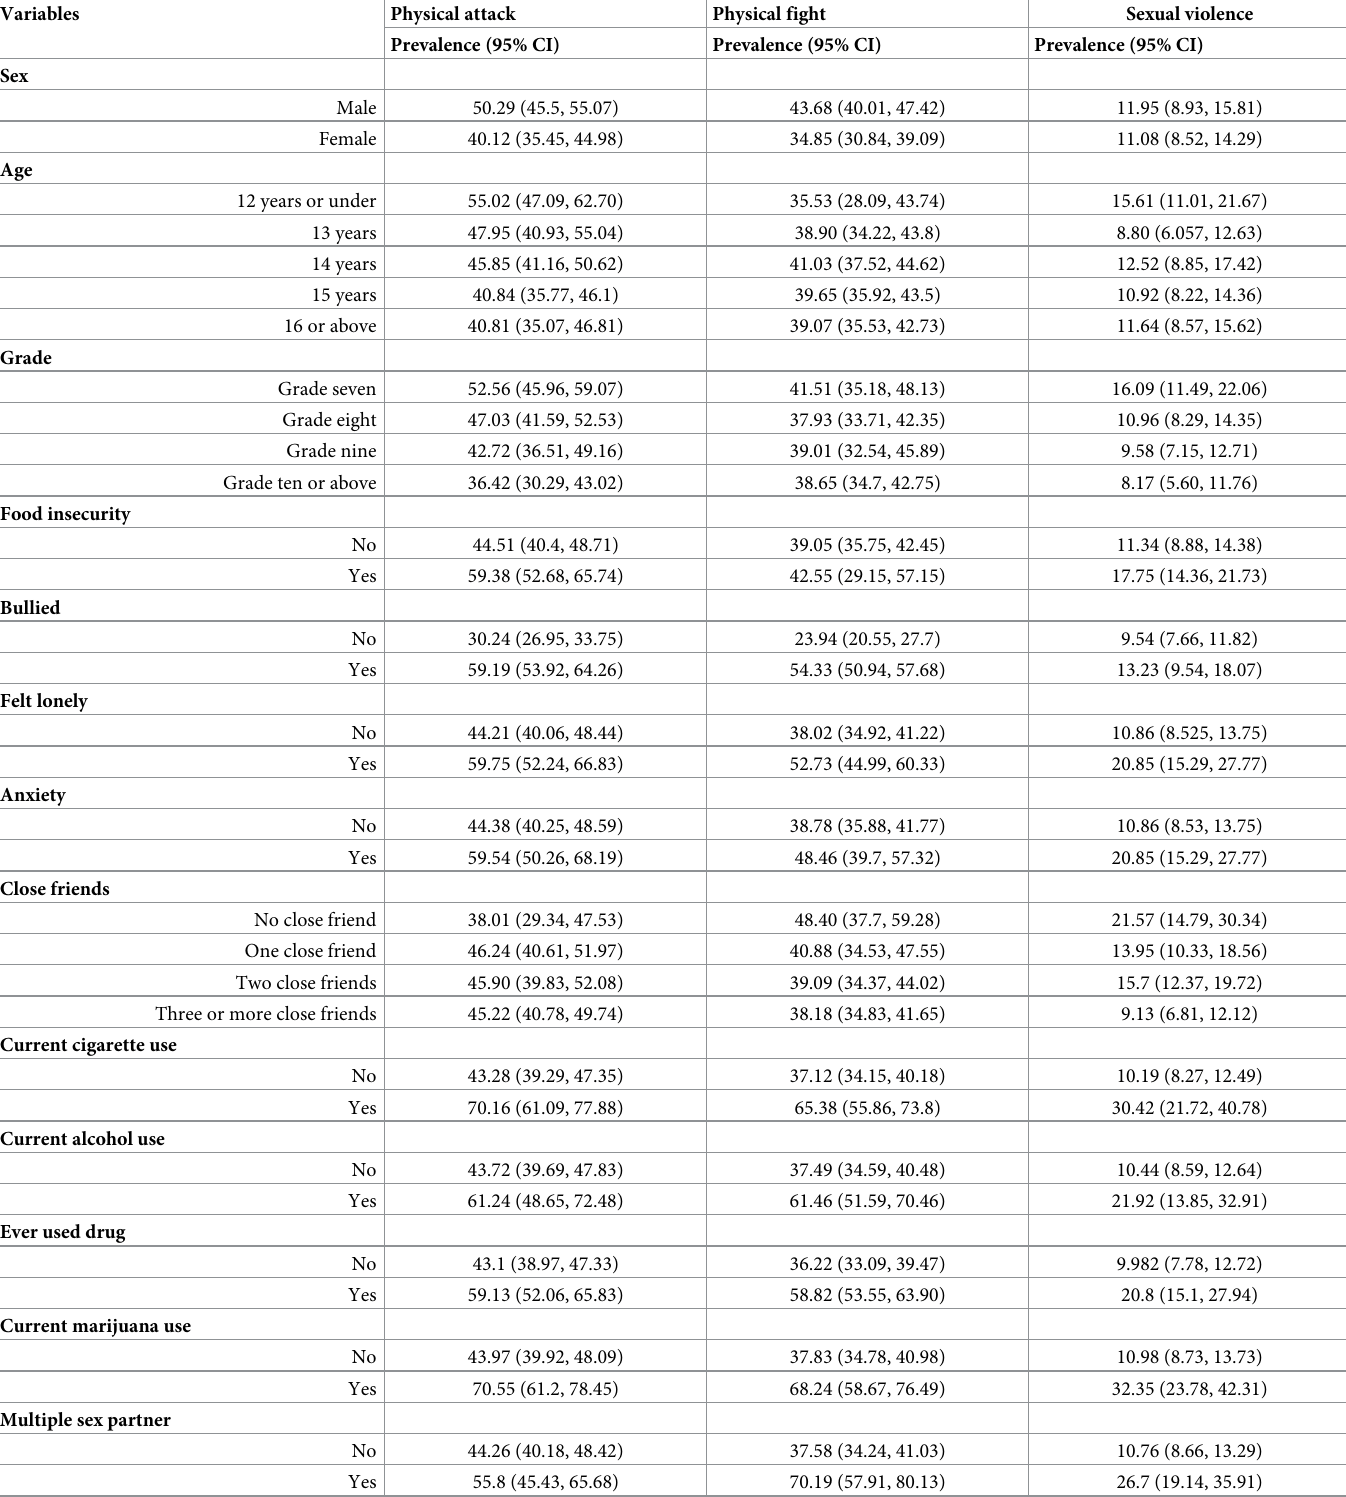
Table 2. Prevalence of physical attack, physical fight, and sexual